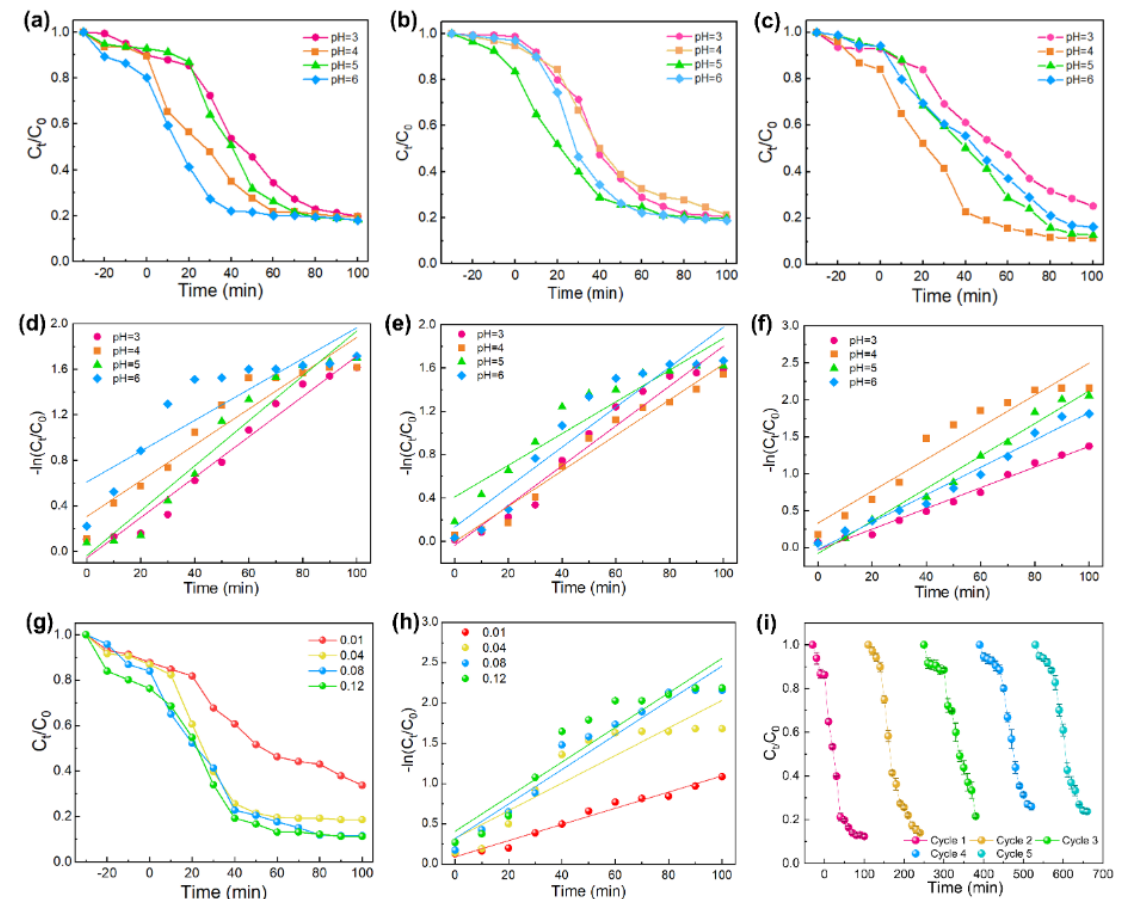
(Figure 4d–f). This combination of the seed layer and ZIF–8 facilitated the photocatalytic performance for TC.